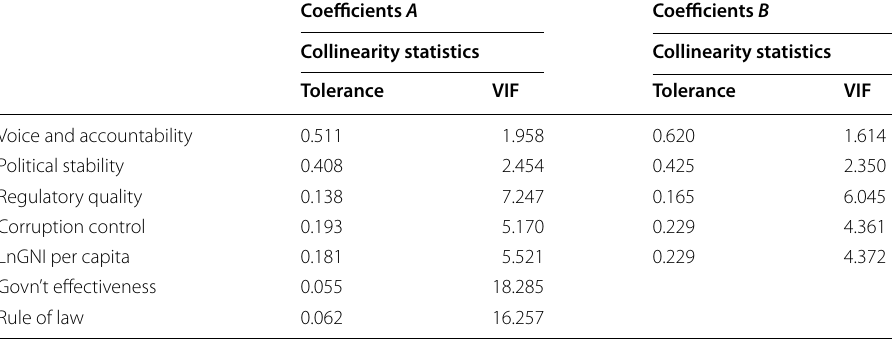
Table 4 Multicollinearity test